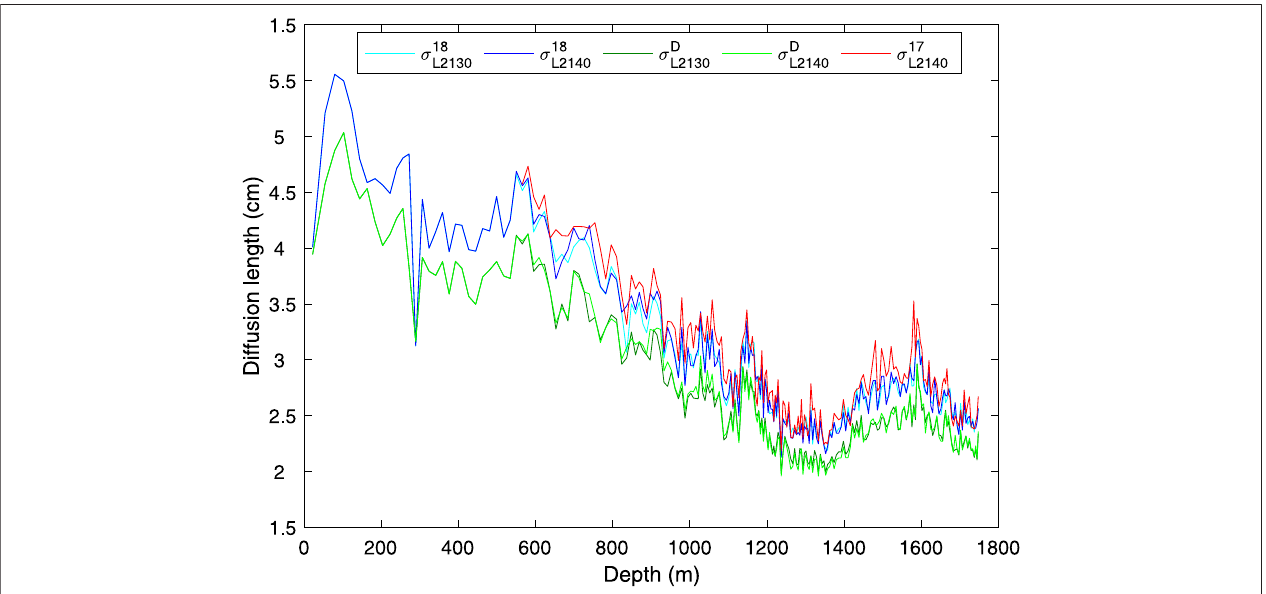
FIGURE 8 | Diffusion lengths, σ , from fi ve different high-resolution isotope-ratio measurements from the South Pole ice core, determined using the methods described inKahle et al. (2018).The superscripts 17, 18, D refer to δ 17 O, δ 18 O, δ D, and the subscripts L2130, L2140 tothe instrument used. All calculations weremade on 250-year windows of the 0.5 cm high-resolution calibrated data, using the ice timescale of (Winski et al., 2019). σ from δ 17 O recalculated for the L2130 ( Eq. 12 , not shown) is indistinguishable from the original data.